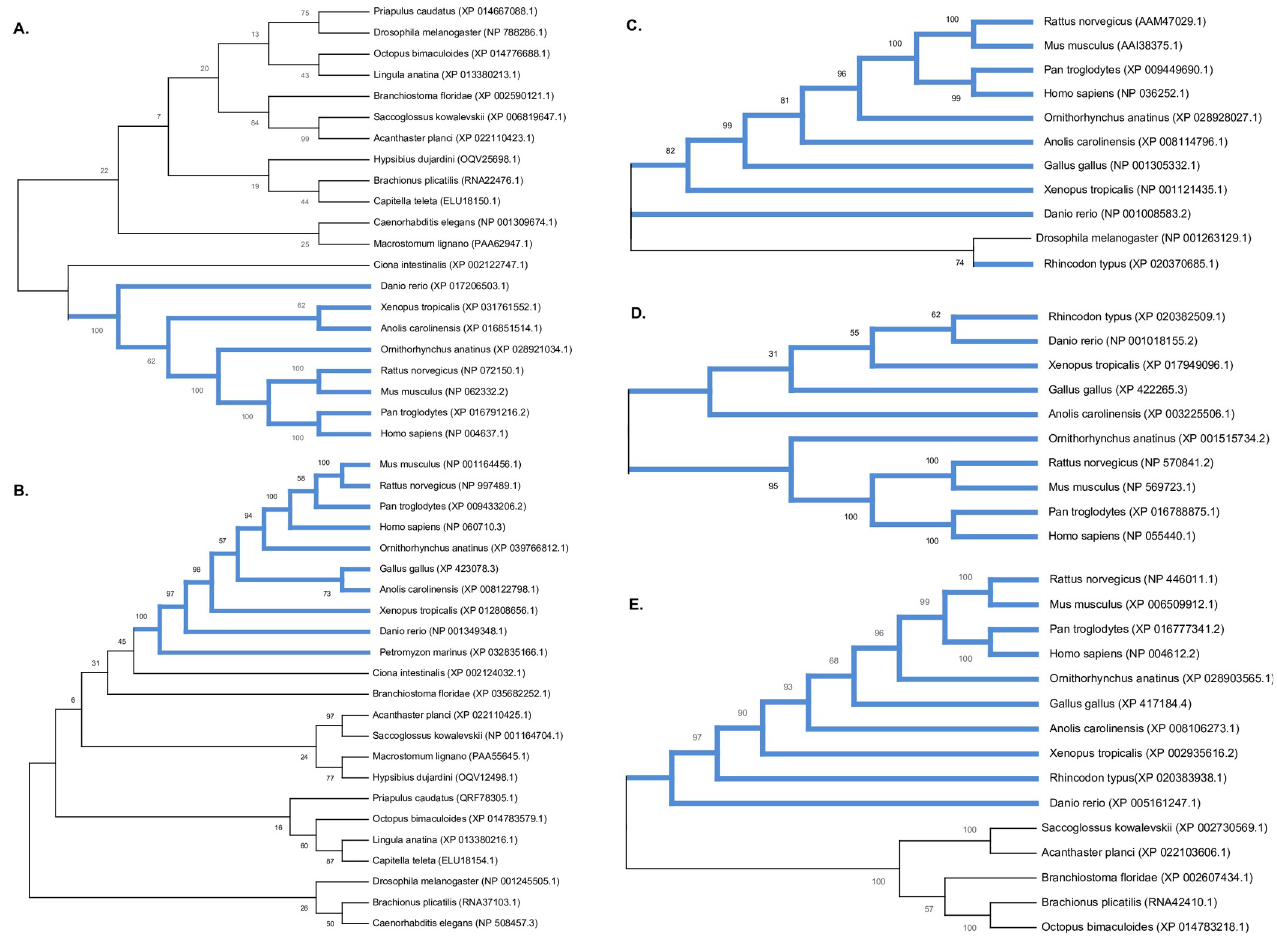
Fig 1. Distribution of SD proteins and their orthologs in vertebrates and invertebrates. A) Nephrin, B) KIRREL1, C) CD2AP, D) Podocin, and E) TRPC6. Only organisms with complete genome sequences were considered for the study. Note: Blue thick lines represent the vertebrate phyla.